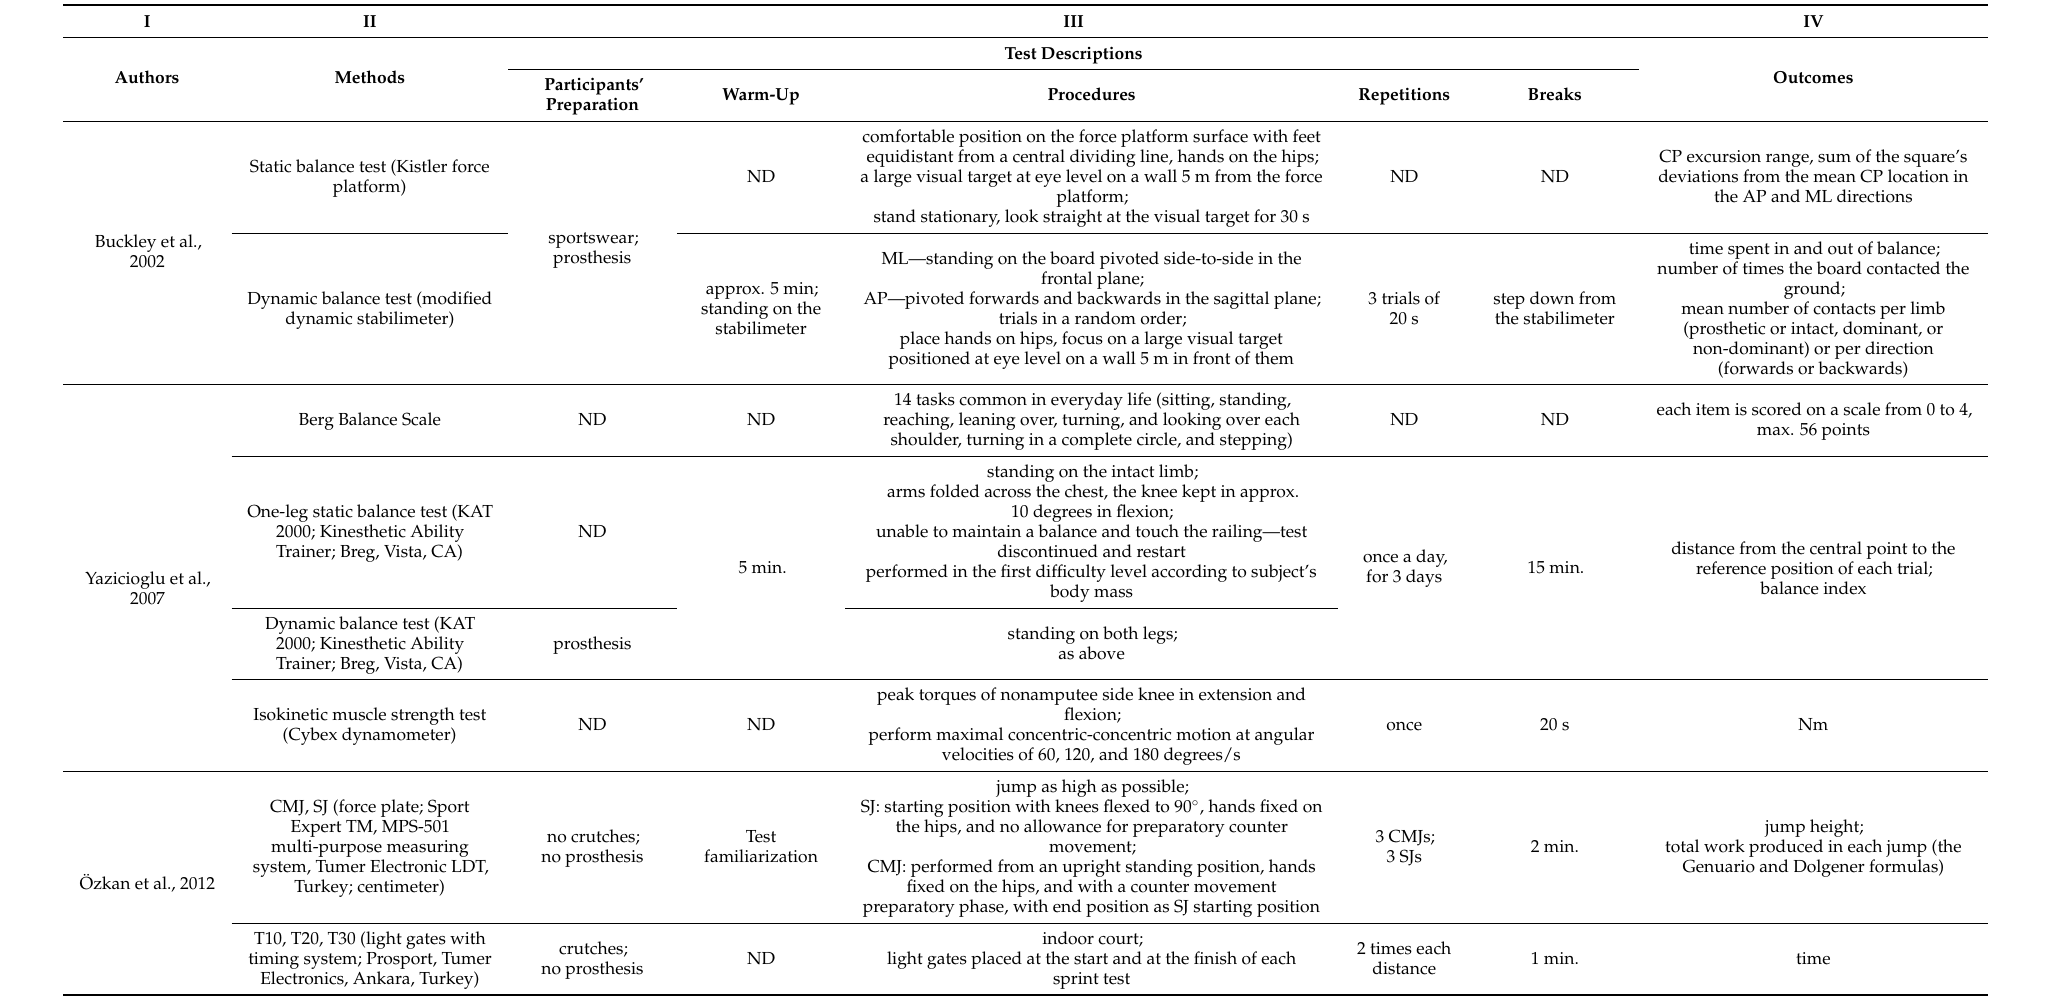
Table 2. A detailed description of the sports performance tests in included